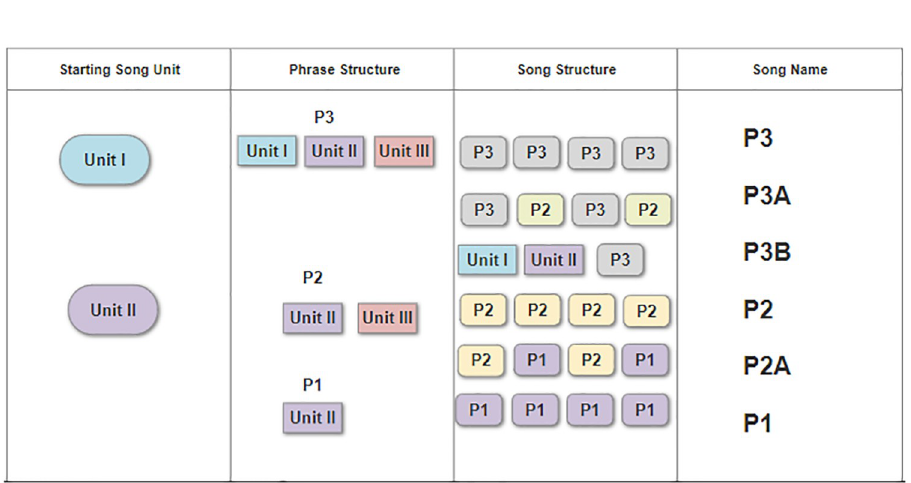
Fig 3. Song structure classification. The SEIO pygmy blue whale song type has three defined units combined in different sequences to produce phrases that are then linked together in song. Phrases are categorised by the order that units appear with temporal variations in the length of phrase types. Songs are generally composed of the same phrase repeated over and over, though combination songs comprised of two different phrases in sequence have been